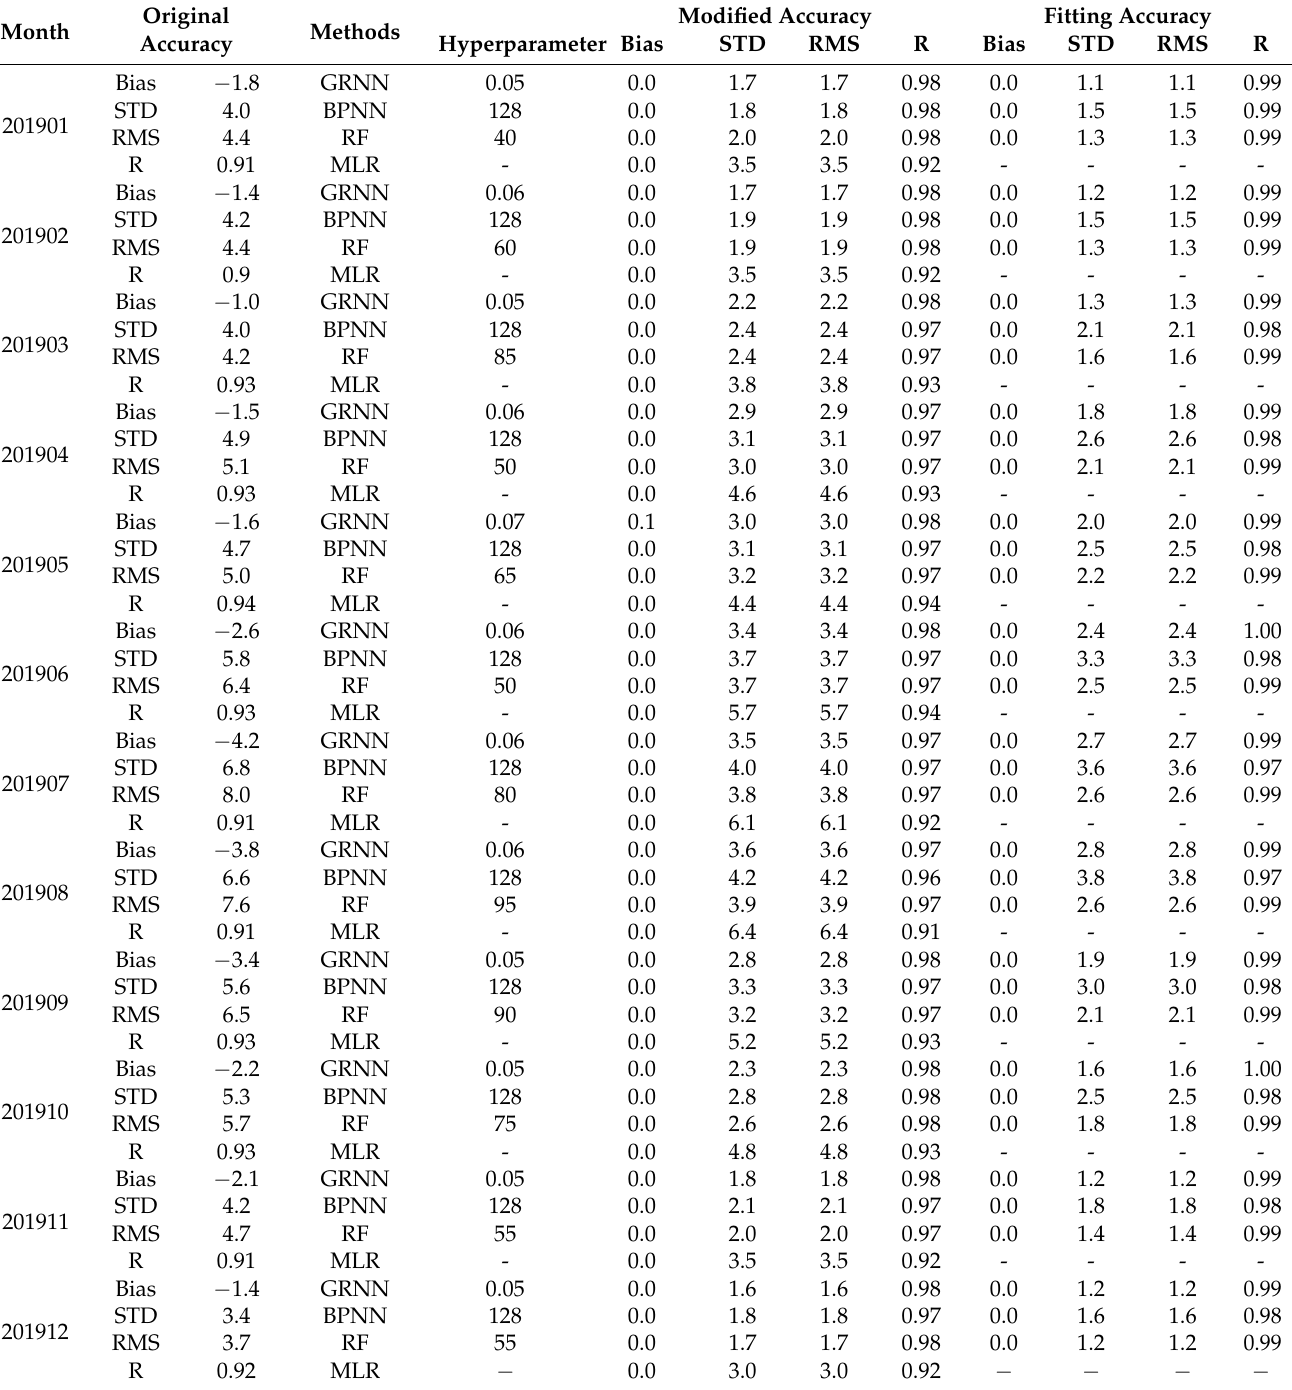
Table 3. Monthly MODIS–GNSS PWV model results compared to GNSS